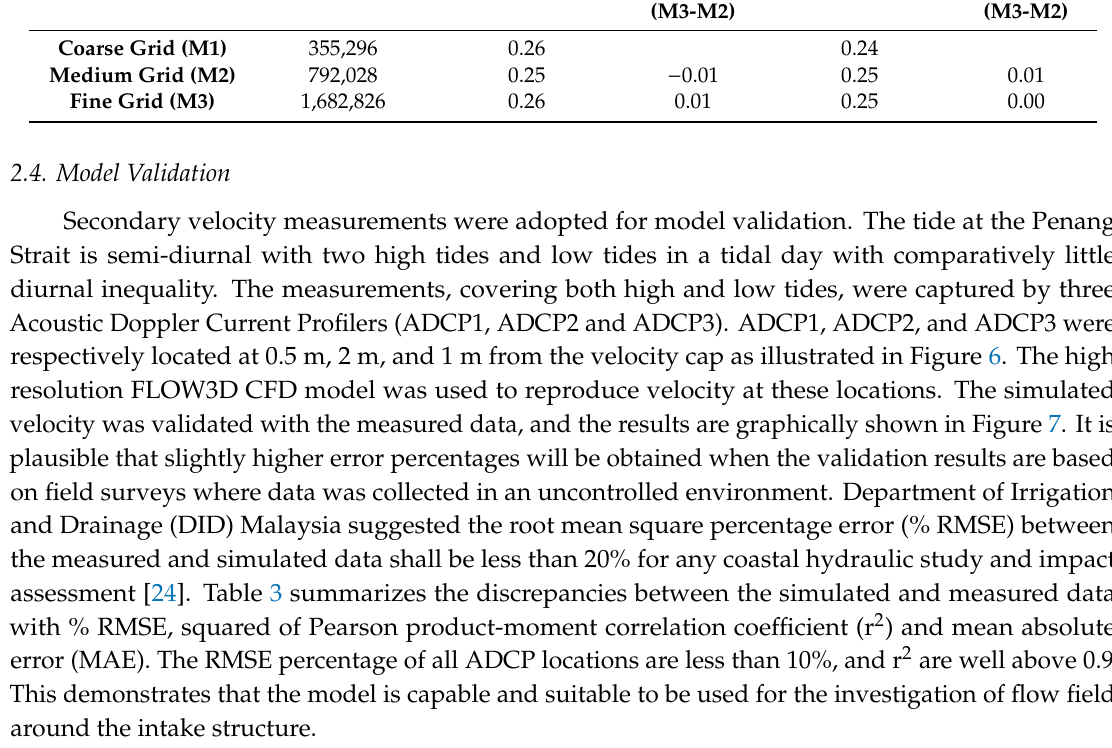
Table 2. Comparison of intake velocity for M1, M2, and M3 grids.